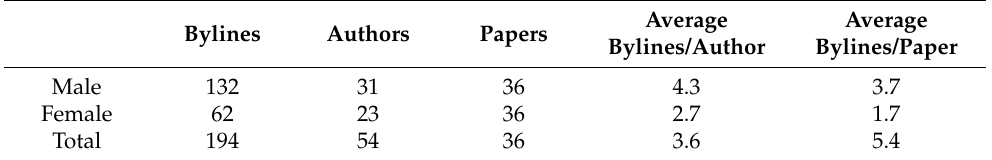
Table 3. Productivity of the authors and collaborators (coauthors). Data separated by gender.